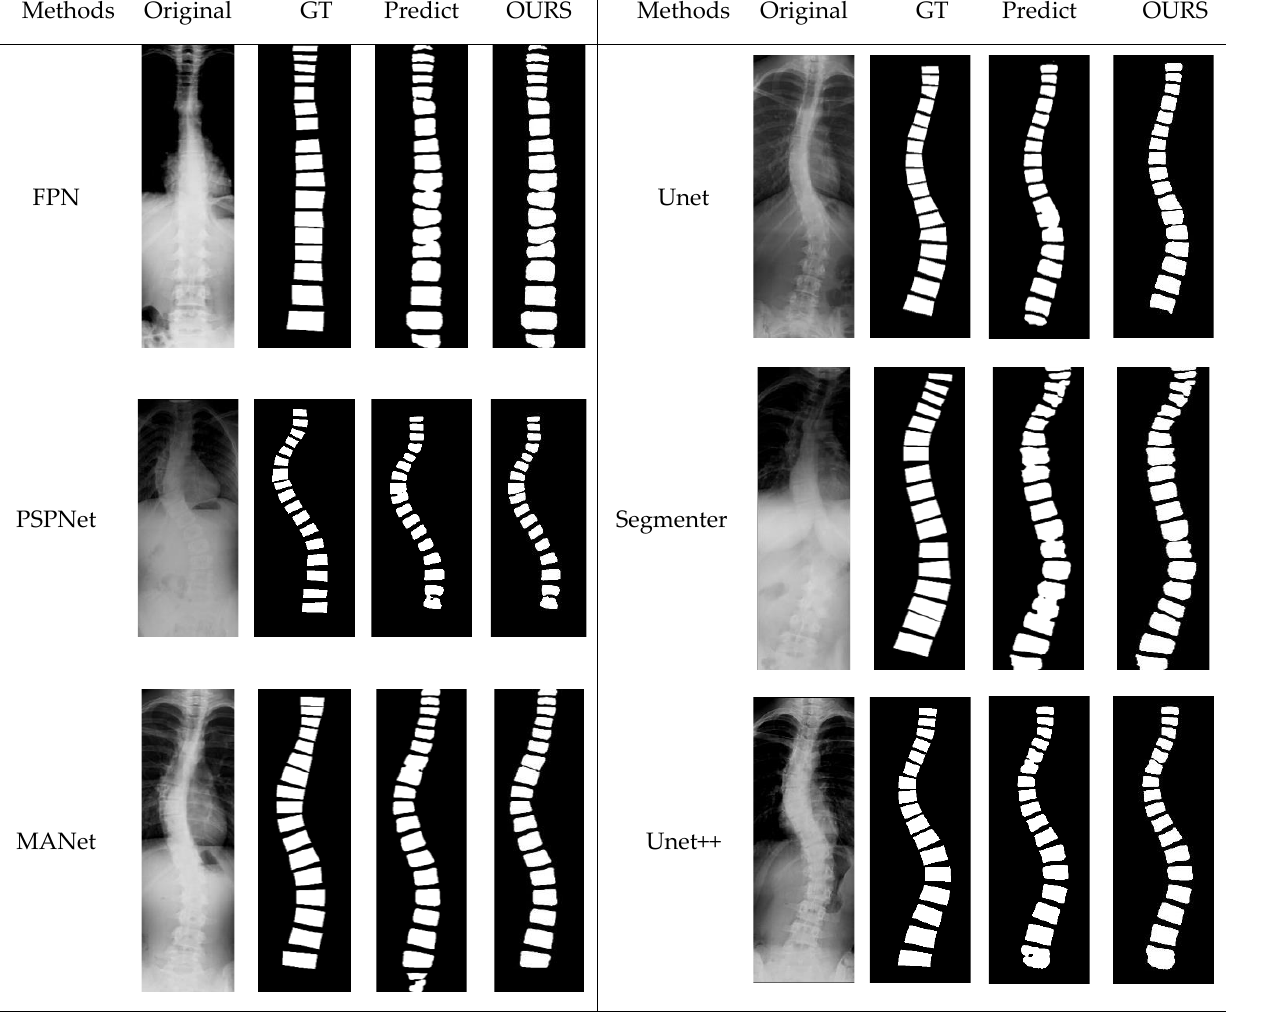
Figure 15. The visual comparison of some examples to illustrate the effects of post-processing. GT: ground truth; Predict: without post-processing; OURS: the post-processing was used. From the above results, the following conclusions can be drawn.